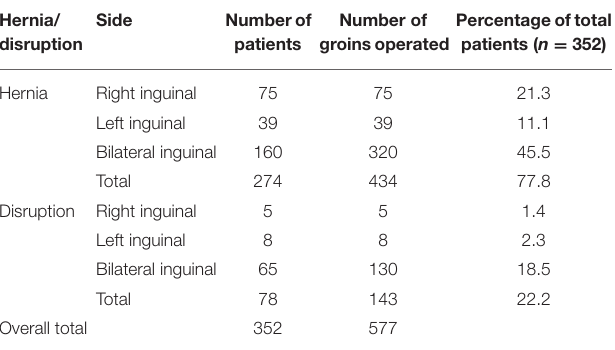
TABLE 2 | Table showing number and percentage of patients as per indication for